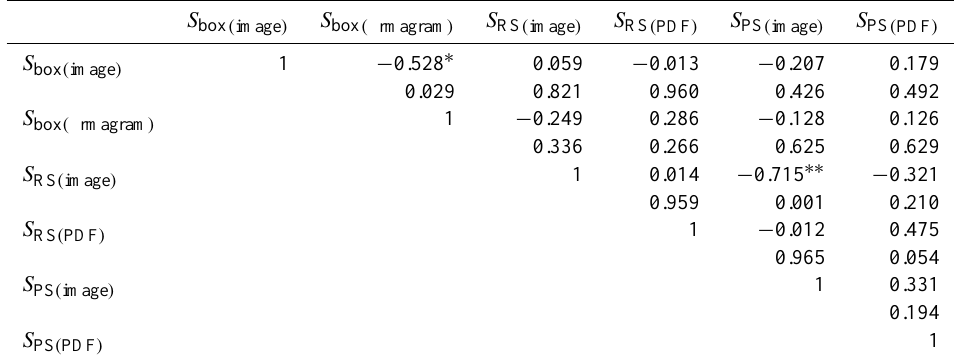
Table 6. Pearson-r correlation matrix for the standard deviations ( S ) of three applied techniques: Box dimension, R / S analysis and Power